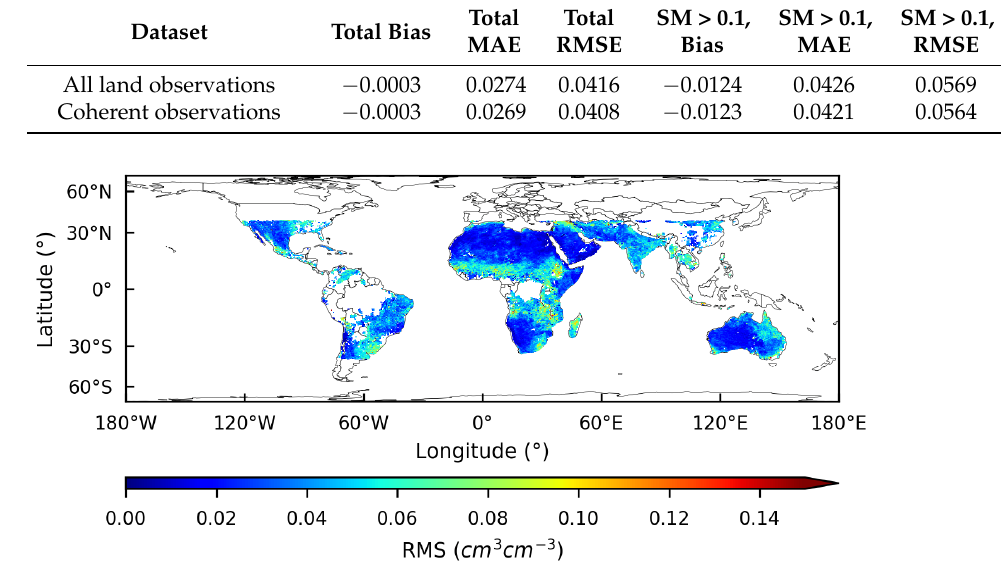
Figure 8. Root-mean-square error (RMSE) of CYGNSS retrieved land surface SM at each